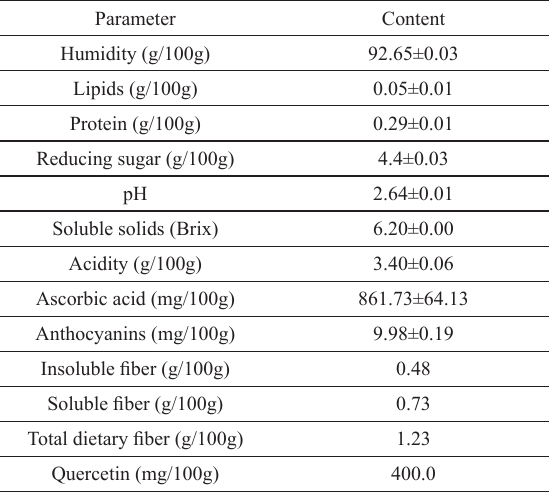
Chemical composition and physical chemical characteristics of Camu-camu pulp.